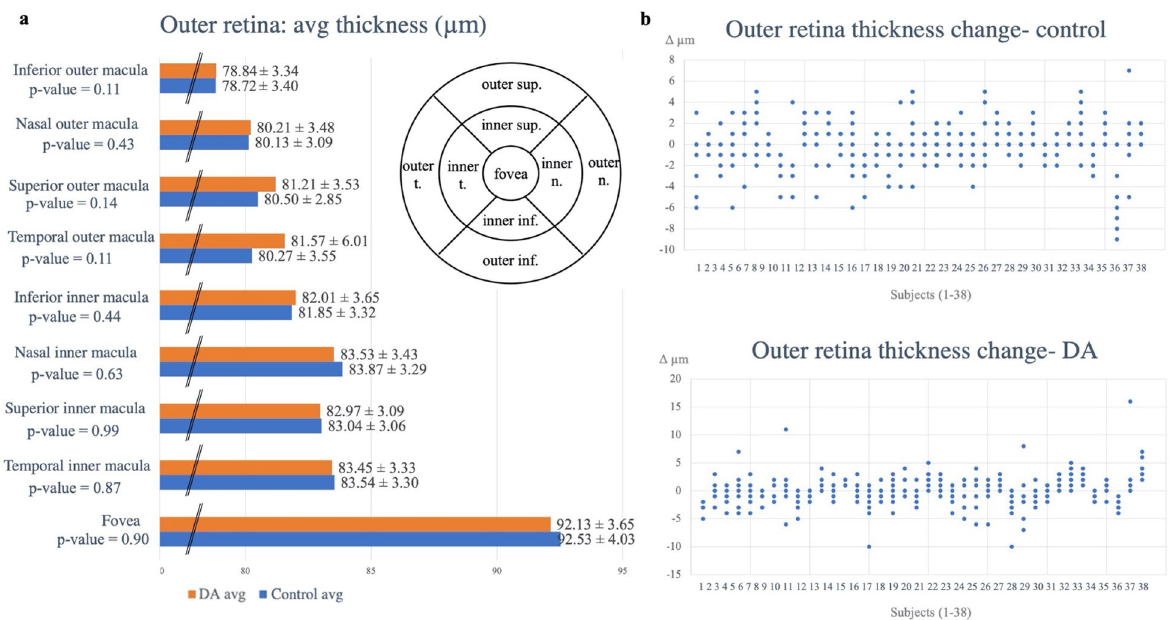
Figure 1. Outer retinal thickness measurements before and after dark adaptation (DA) at baseline and four hours later in the dark adapted and control eyes. ( A ) Bar graph comparing dark adapted (orange) and control (blue) average thickness measurements for the 9 regions of interest (foveal, and inner and outer perifoveal regions) with a labeled thickness map example template included (superior-sup., nasal-n., temporal-t., inferior- inf.). ( B ) Average differences for the outer retinal layer for control and dark adaptation conditions respectively. Data points were taken from the Heidelberg-generated thickness maps from all 9 regions (foveal and inner and outer perifoveal regions) for each subject, and the values before the dark adaptation period were subtracted from those after the dark adaptation period to calculate the difference in values. Negative values show layer